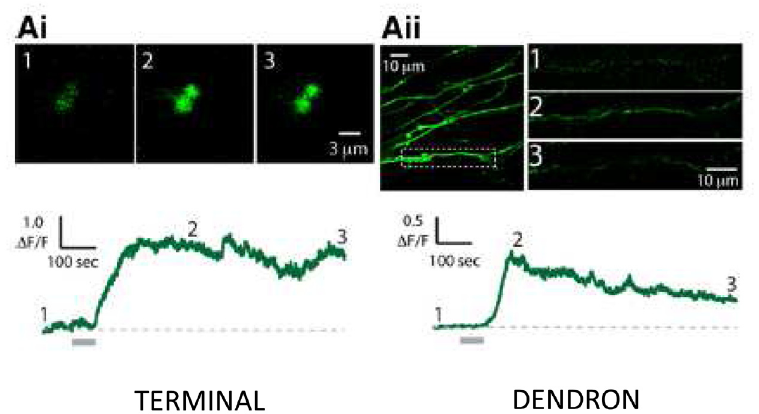
Figure 4. Kisspeptin elicits Ca ++ increases in GnRH dendrons and terminals in the mouse median eminence. One-minute discharges (“puffs”) of kisspeptin from a pipette locally applied to GnRH nerve terminals and dendrons in hypothalamic slices elicit increases in intracellular Ca ++ (the trigger for GnRH release) monitored by the Ca ++ indicator, GCaMP6 (green fluorescence), expressed in GnRH neurons of transgenic mice. Lower traces, Ca ++ responses to a kisspeptin puff (horizontal gray bar) on a GnRH terminal ( Ai ) or dendron ( Aii ). The fluorescent signals observed at times 1, 2, and 3 on the Ca ++ traces are shown above. Δ F/F, relative increase in fluorescence over baseline; GnRH, gonadotropin- releasing hormone. Reproduced from Iremonger et al. 53 with permission of the Society for